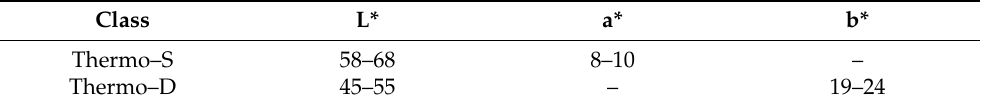
Table 2. Current colour guidelines for ThermoWood ® Norway spruce and Scots pine as defined within quality control document FC-2 Thermally Modified Timber (TMT) 2014